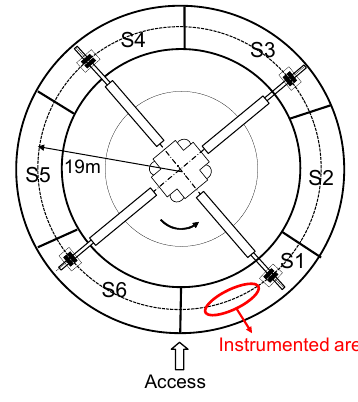
Figure 12. Dual wheel loading dimensions.